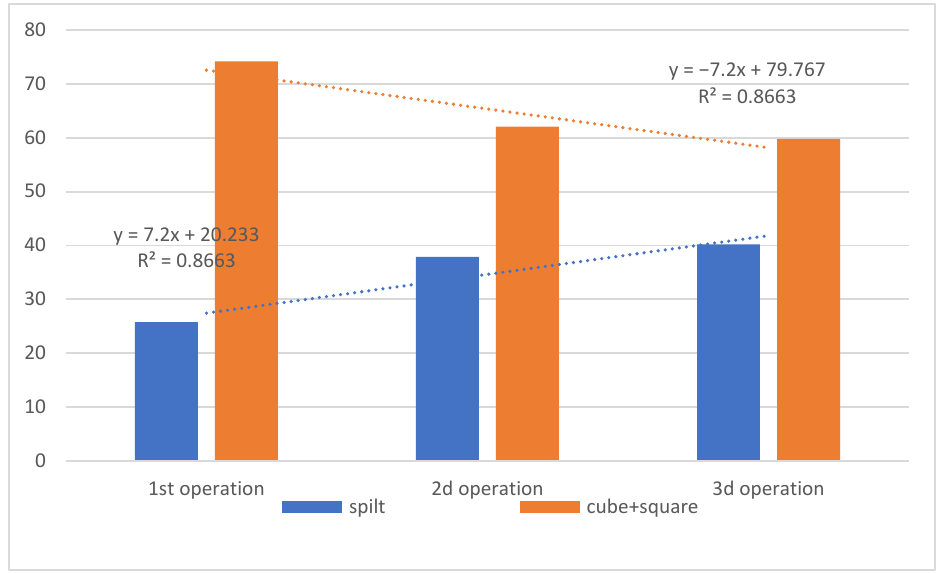
Figure 10. The experimental results: comparison of cubic together with square and spilt fragment forms’ distribution based on the average values for the 1st experiment. Approximating curve shows these changes.